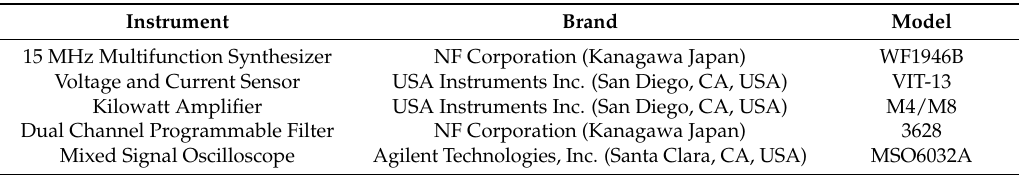
Table 6. The instruments included in the electroacoustic measurement system.